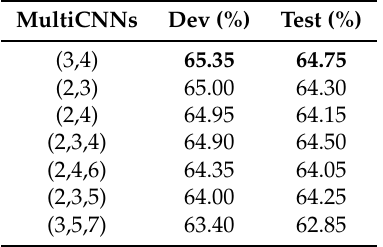
Table 4. Results of different types of feature maps.